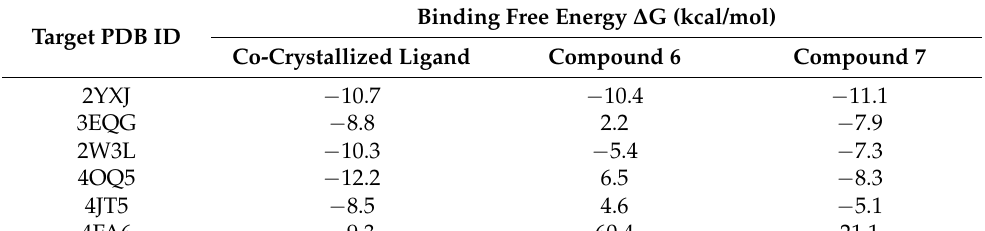
Table 5. Recorded docking scores for compounds 6 and 7 (binding energy, ∆ G kcal/mol).